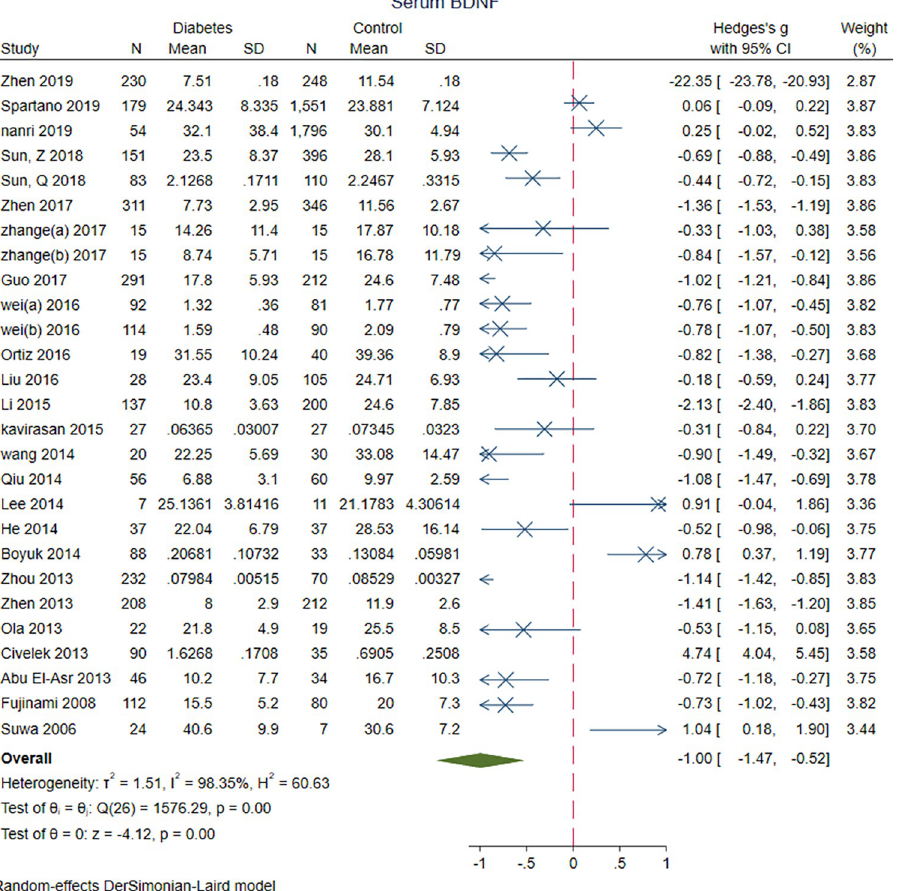
Fig 2. A meta-analysis of serum BDNF levels in patients with DM vs. controls.